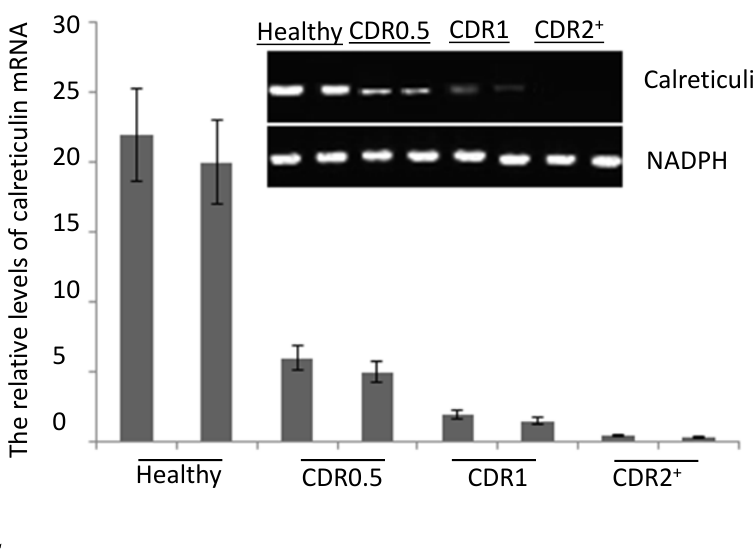
Figure 1. Quantitative RT-PCR analysis for the calreticulin mRNA levels in serum of Alzheimer’s disease (AD) patients and healthy participants. Quantitative RT-PCR analysis showed higher levels of calreticulin mRNA in healthy subjects than those in AD patients. Each bar represents the mean ± S.D. of three independent experiments.